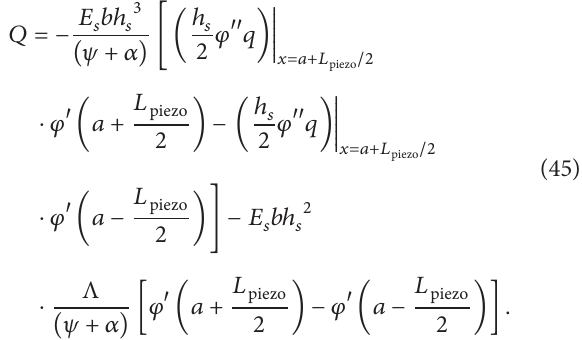
Figure 5: The variation curve of positional force coefficient Π along with the changing of PZT position on the